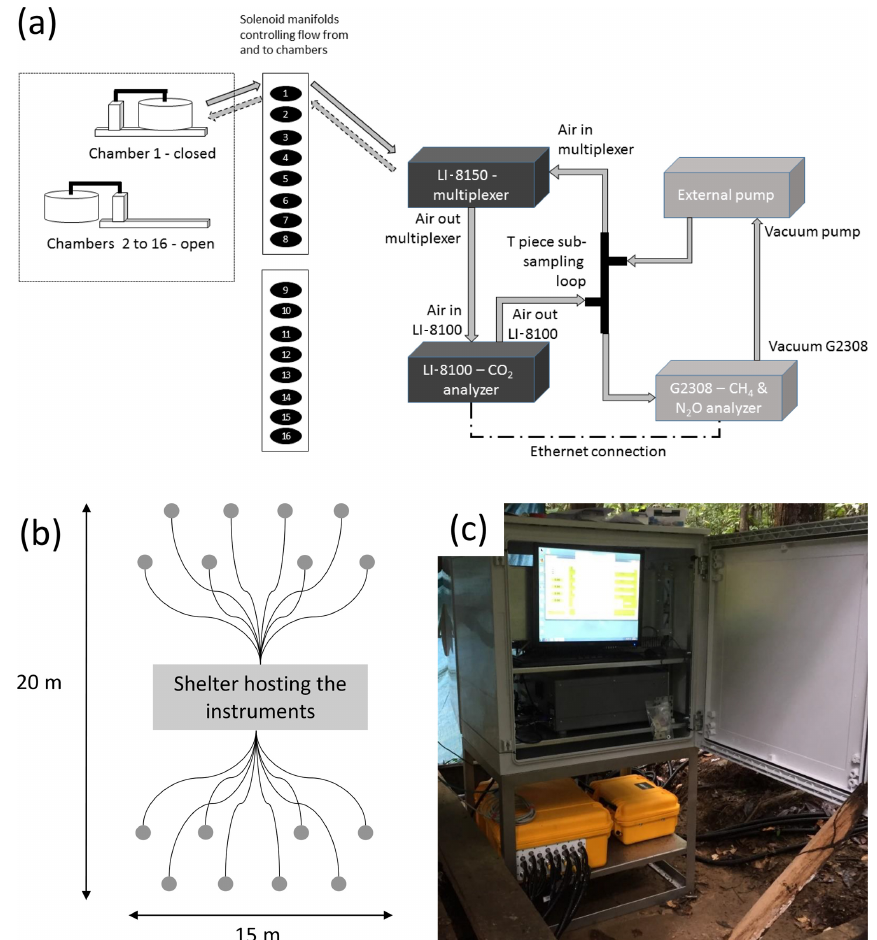
Figure 1. Experimental design. (a) Schematic view of the installation composed of four main components: 16 automated long-term chambers (8100-104, LI-COR Biosciences), a multiplexer to link one of these chambers to the gas analyzers (LI-8150, LI-COR Biosciences), an in- frared gas analyzer (IRGA) to measure CO 2 concentrations (LI-8100A, LI-COR Biosciences), and a cavity ring-down spectroscopy (CRDS) instrument to measure CH 4 and N 2 O concentrations (G2308, Picarro) that was fitted with an external pump. (b) Schematic representation of the grid with the shelter housing the equipment in the middle and the 16 chambers (grey dots) linked to the LI-8150 multiplexer with 15m cables (black lines). (c) Picture of the instruments in the field.